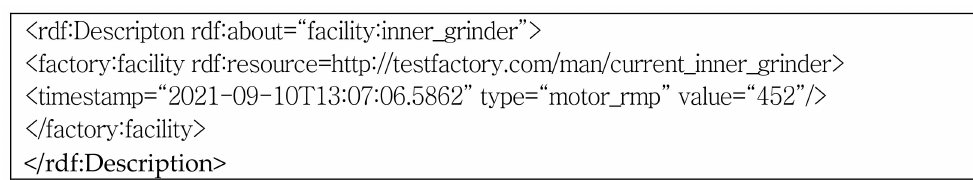
Figure 12. Xml to rdf